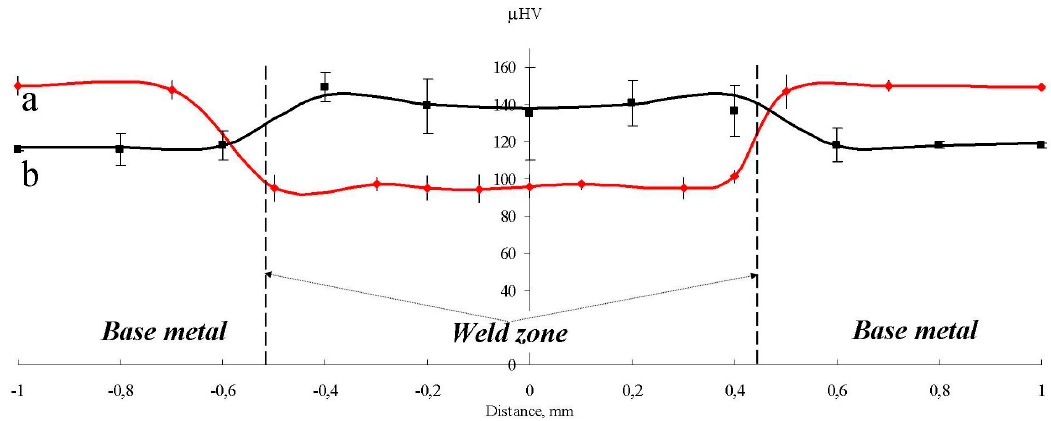
Figure 5. Microhardness over the cross-section of weld zone: ( a ) 1545 K welded with AlTiB; and ( b ) 1545 K welded with AlTiB and annealed at 370 °C 6 h.